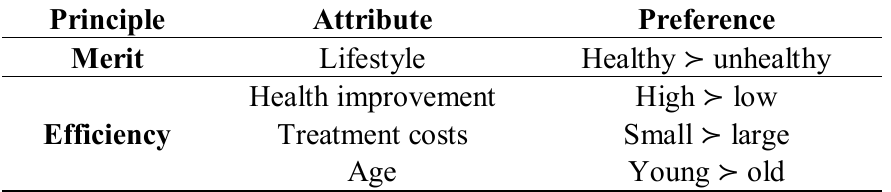
Table 1. Attributes representing the principles of distributive